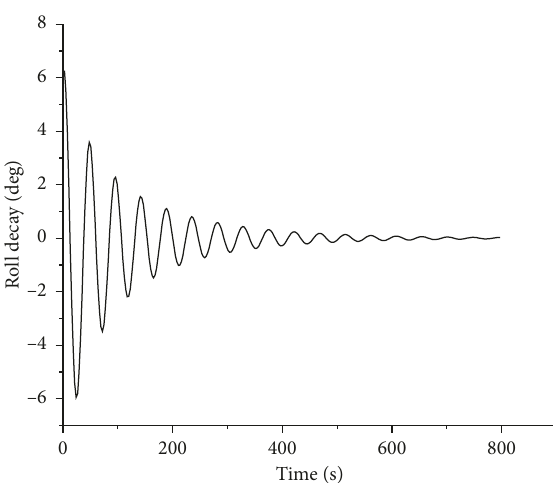
Figure 12: Decay curve of pitch